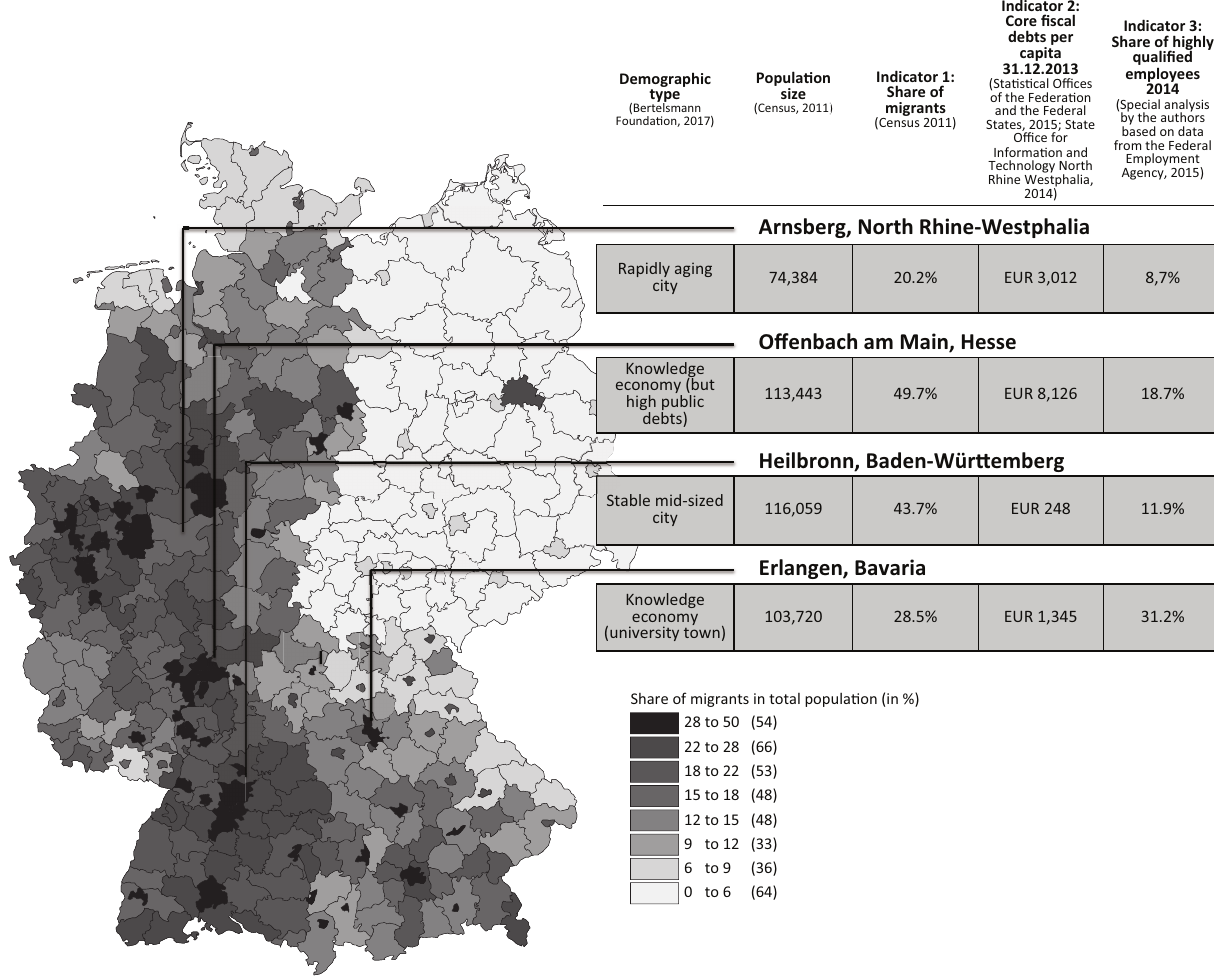
Figure 1. City characteristics of the four urban case studies in Germany. of highly qualified employees (18.7%) due to its vicinity to the global metropolitan region of